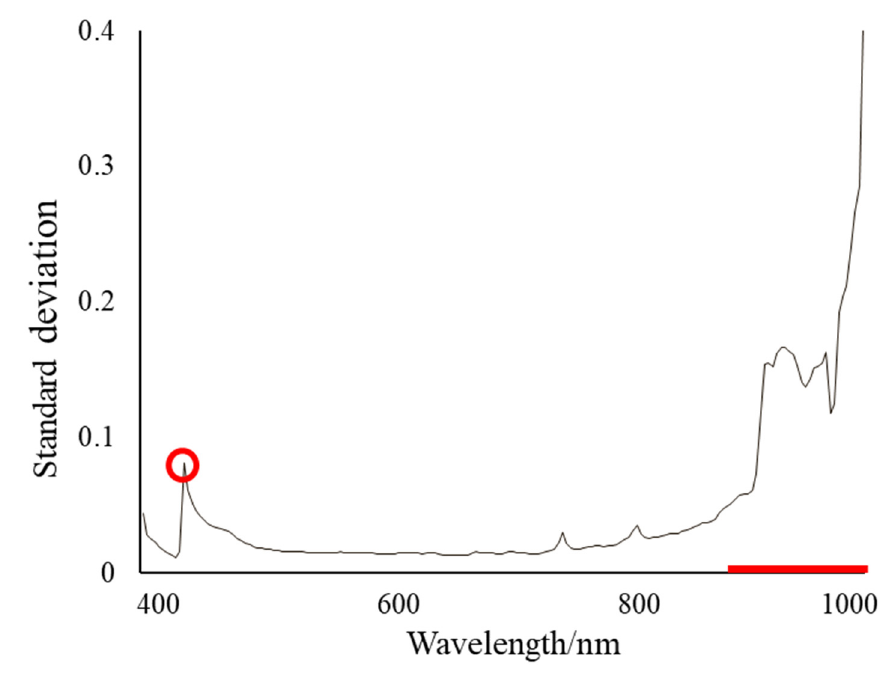
Figure 4. The estimated noise standard deviation of hyperspectral reflectance image.